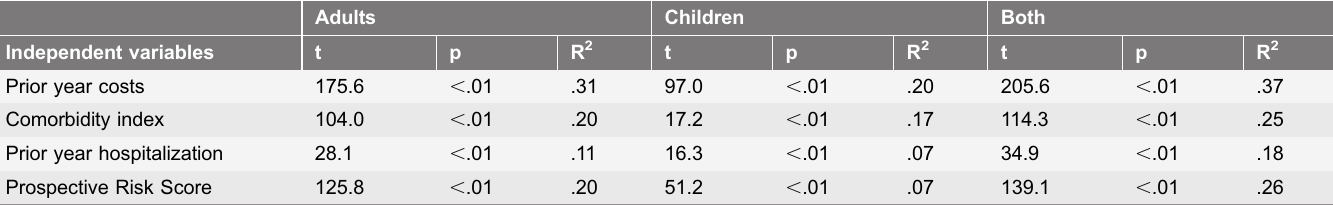
Each model had only the single independent variable in the first column, controlling for age, gender and mental health diagnosis. t indicates the strength of the association and the p value the statistical significance. R 2 is the explained variance, that is, the extent to which the prior year variables predict subsequent year costs; the higher the R 2 , the greater the explanatory or predictive power.